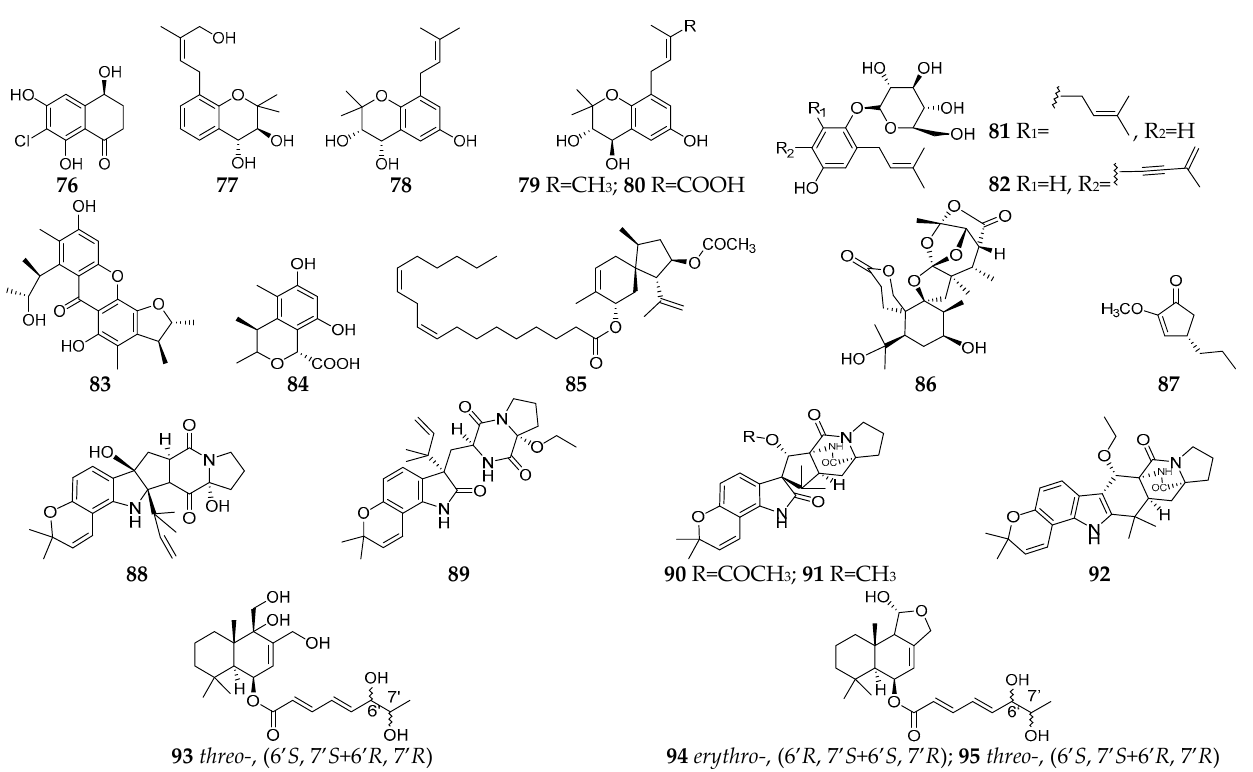
Figure 4. New SMs ( 76 – 95 ) isolated from fungal–fungal co-cultures using rice solid medium.